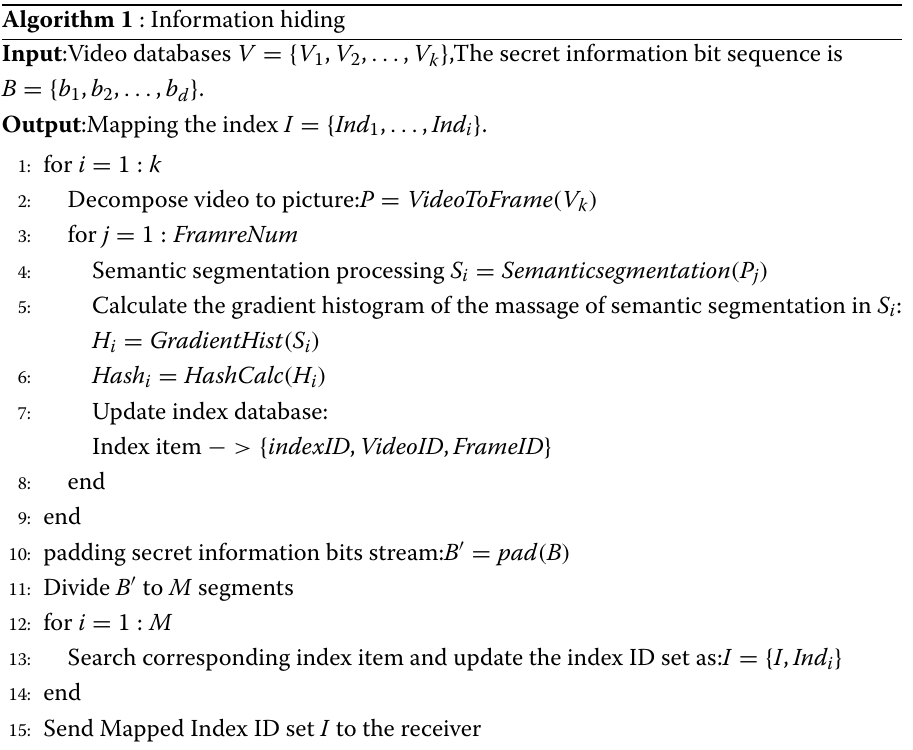
Algorithm 1 : Information hiding